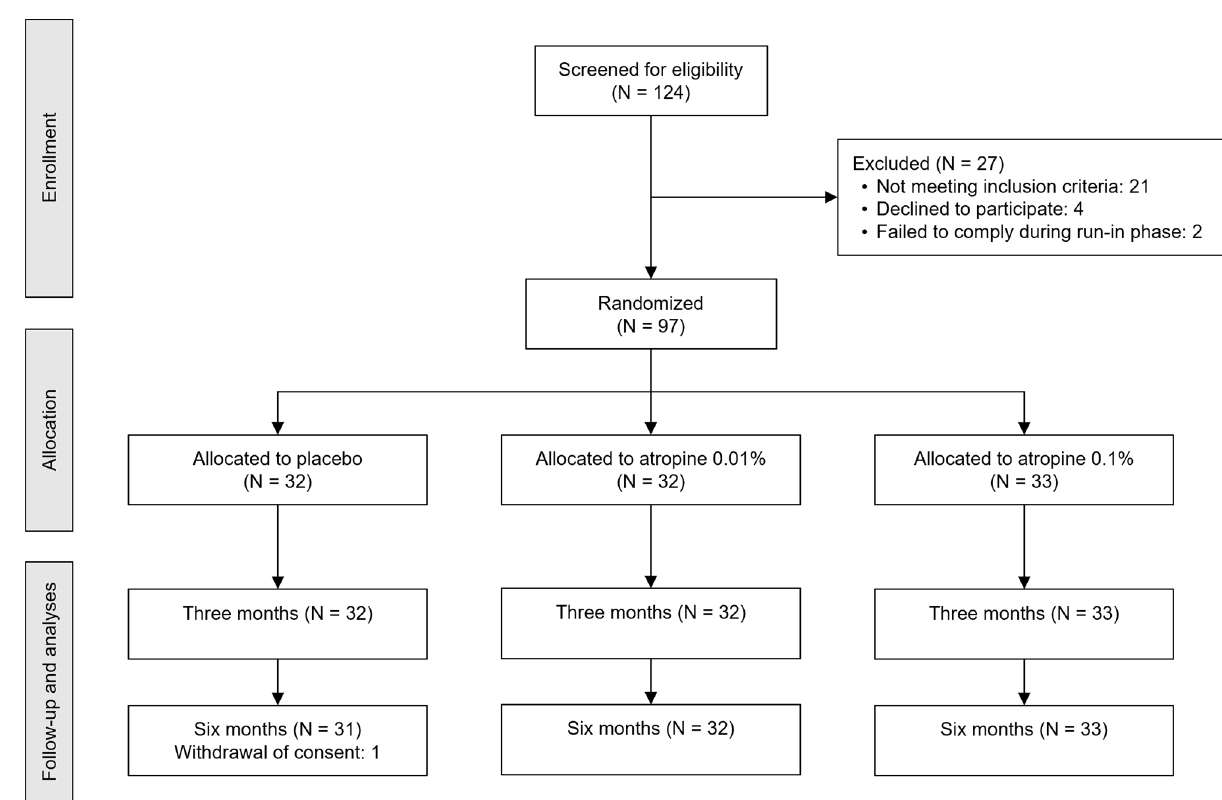
Figure 1. CONSORT diagram for the flow of participants. Notes: The run-in phase consisted of at-home administration of lubricant eye drops to access and maximize future treatment adherence. Abbreviations: CONSORT = consolidated standards of reporting trials; N = number of participants.